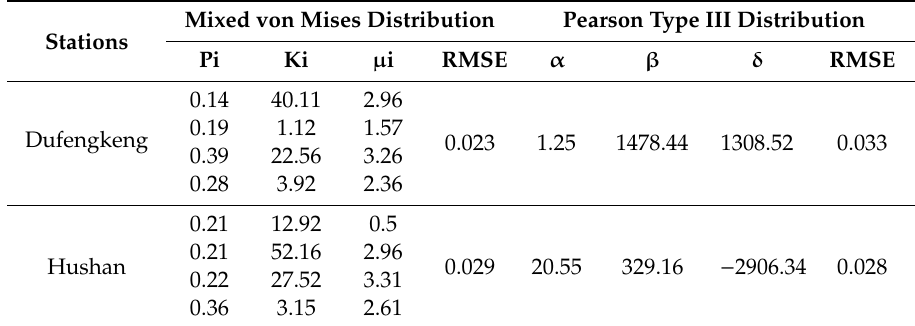
Table 5. Marginal distribution parameters and RMSE between the theoretical probability and the empirical frequency for Dufengkeng Station and Hushan Station in the reference period.